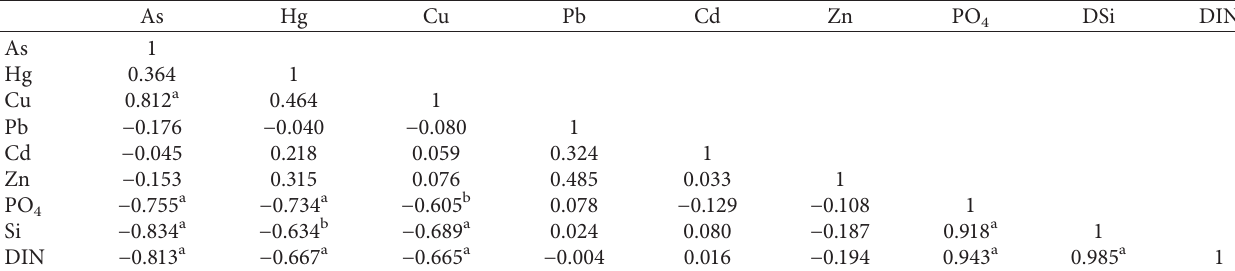
Table 5: Matrix chart of correlation coefficients among the heavy metals in the seawater.